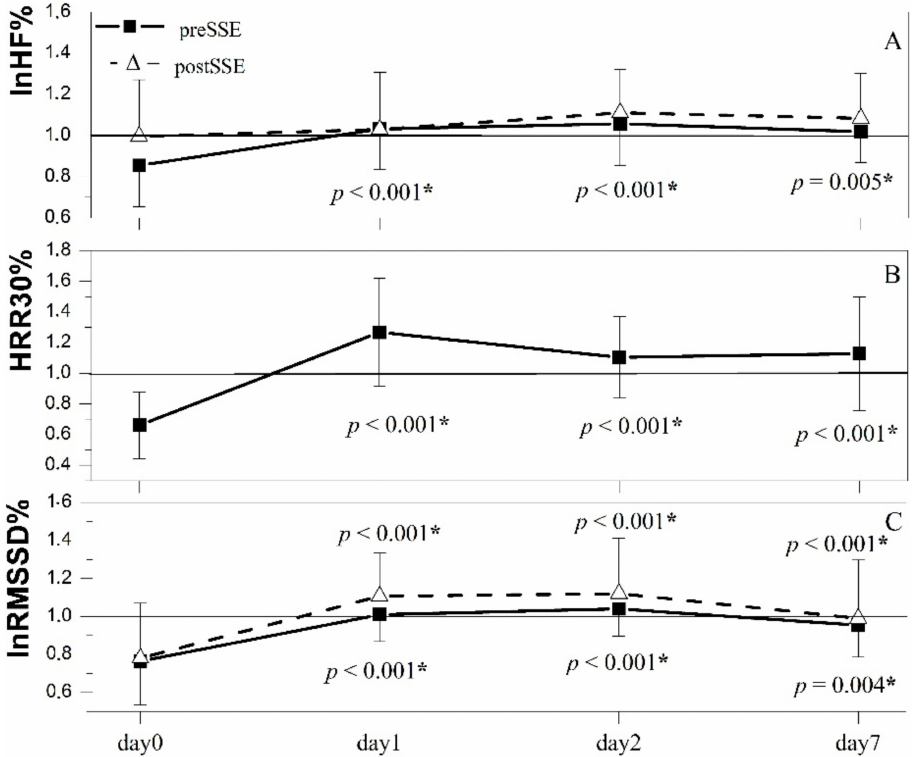
Figure 3. The time course of the change in cardiac parasympathetic activity indices versus baseline represented by lnHF% ( A ), HRR30% ( B ), and lnRMSSD% ( C ) over the experimental trail (day0—1 h after PE, day1—1 day after PE, day2—2 days after PE, day7—one week after PE). lnHF%—the ratio of ln transform of high-frequency power of frequency domain heart rate variability measured in normalized units at each particular time point after PE and corresponding baseline value; HRR30%— the ratio of heart rate recovery in 30 s after exercise cessation at each particular time point after PE and corresponding baseline value; lnRMSSD%—the ratio of ln transform of root mean square of successive interval differences of time domain heart rate variability at each particular time point after PE and corresponding baseline value; PE—prolonged exertion; SSE—short-lasting submaximal exercise. Values are represented as mean ± standard deviation. *—statistically significant compared to day0, p —corresponding p